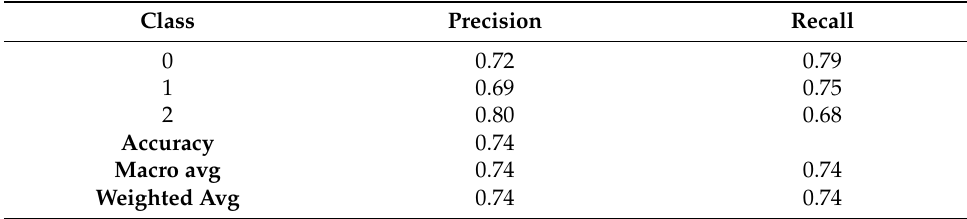
Figure 8. Confusion matrix of Random Forest classifier. Table 7. Classification Gradient Boost